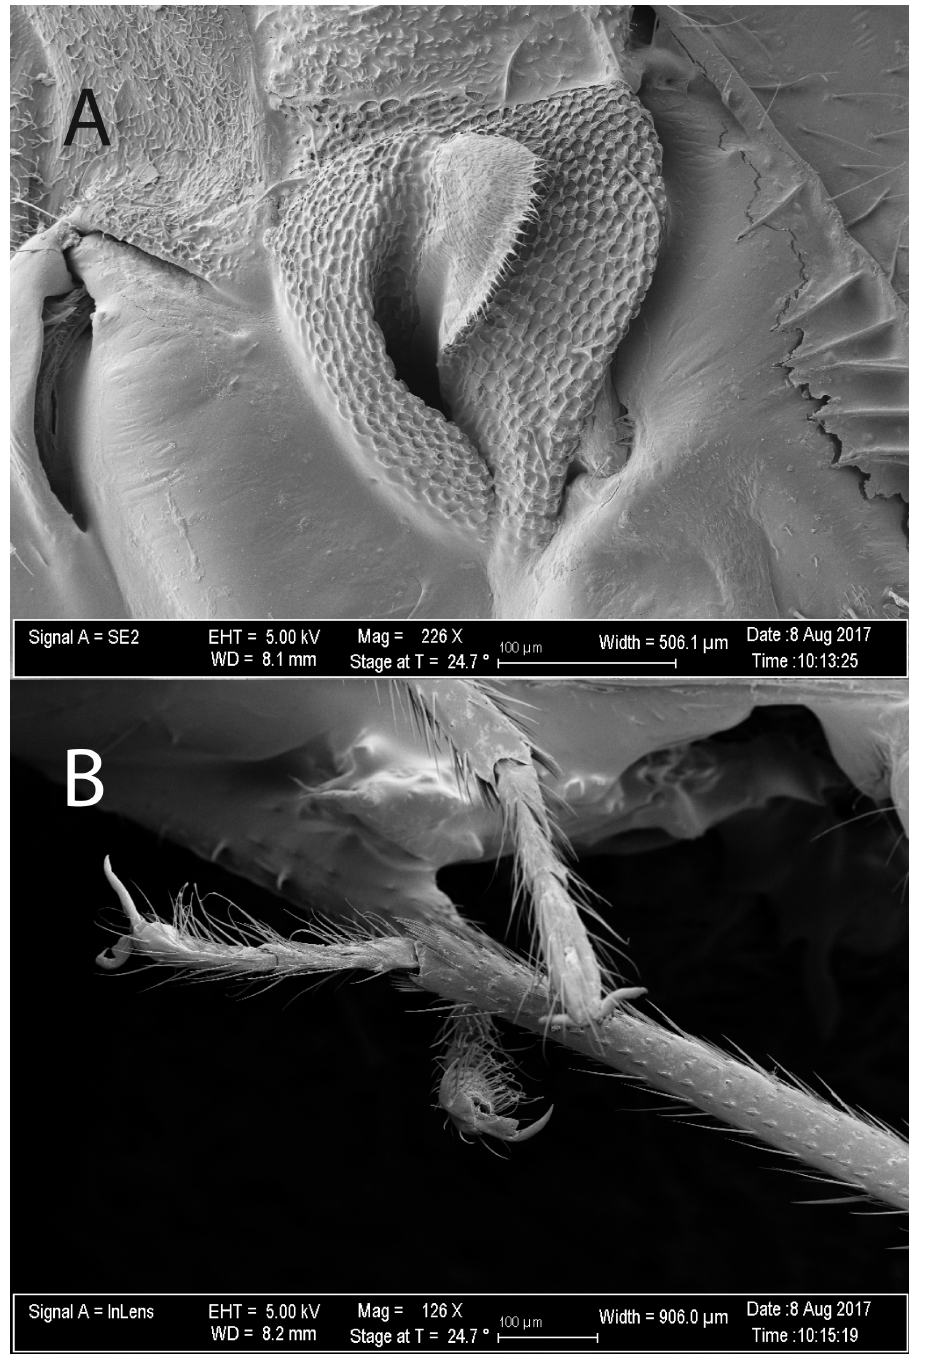
Figure 3. Scanning Electron Micrographs of Philicoris mayon sp. n. visualizing the A scent gland evapo- rative area, and B the